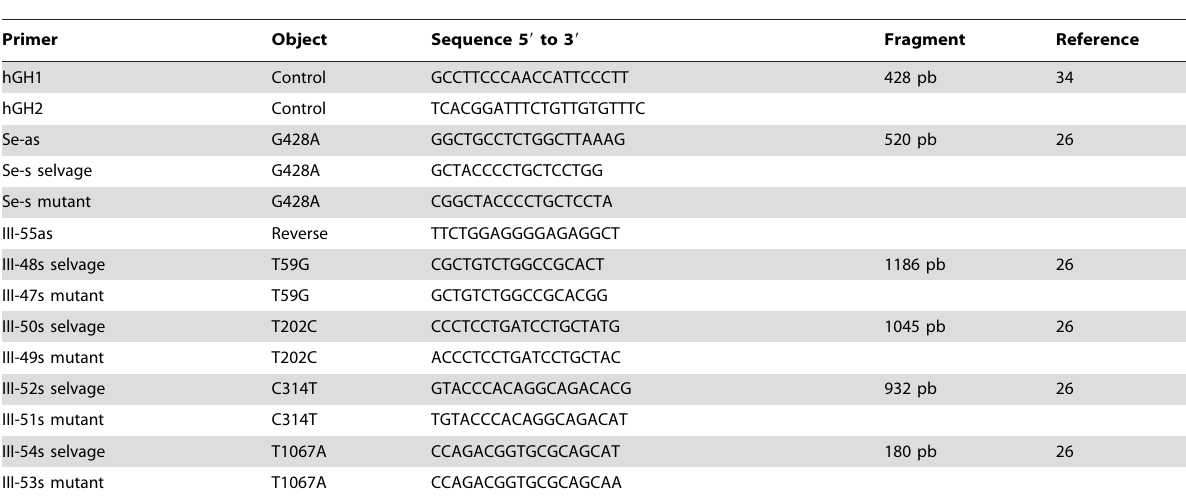
Table 2. Set of primers used for detecting mutations in FUT3.